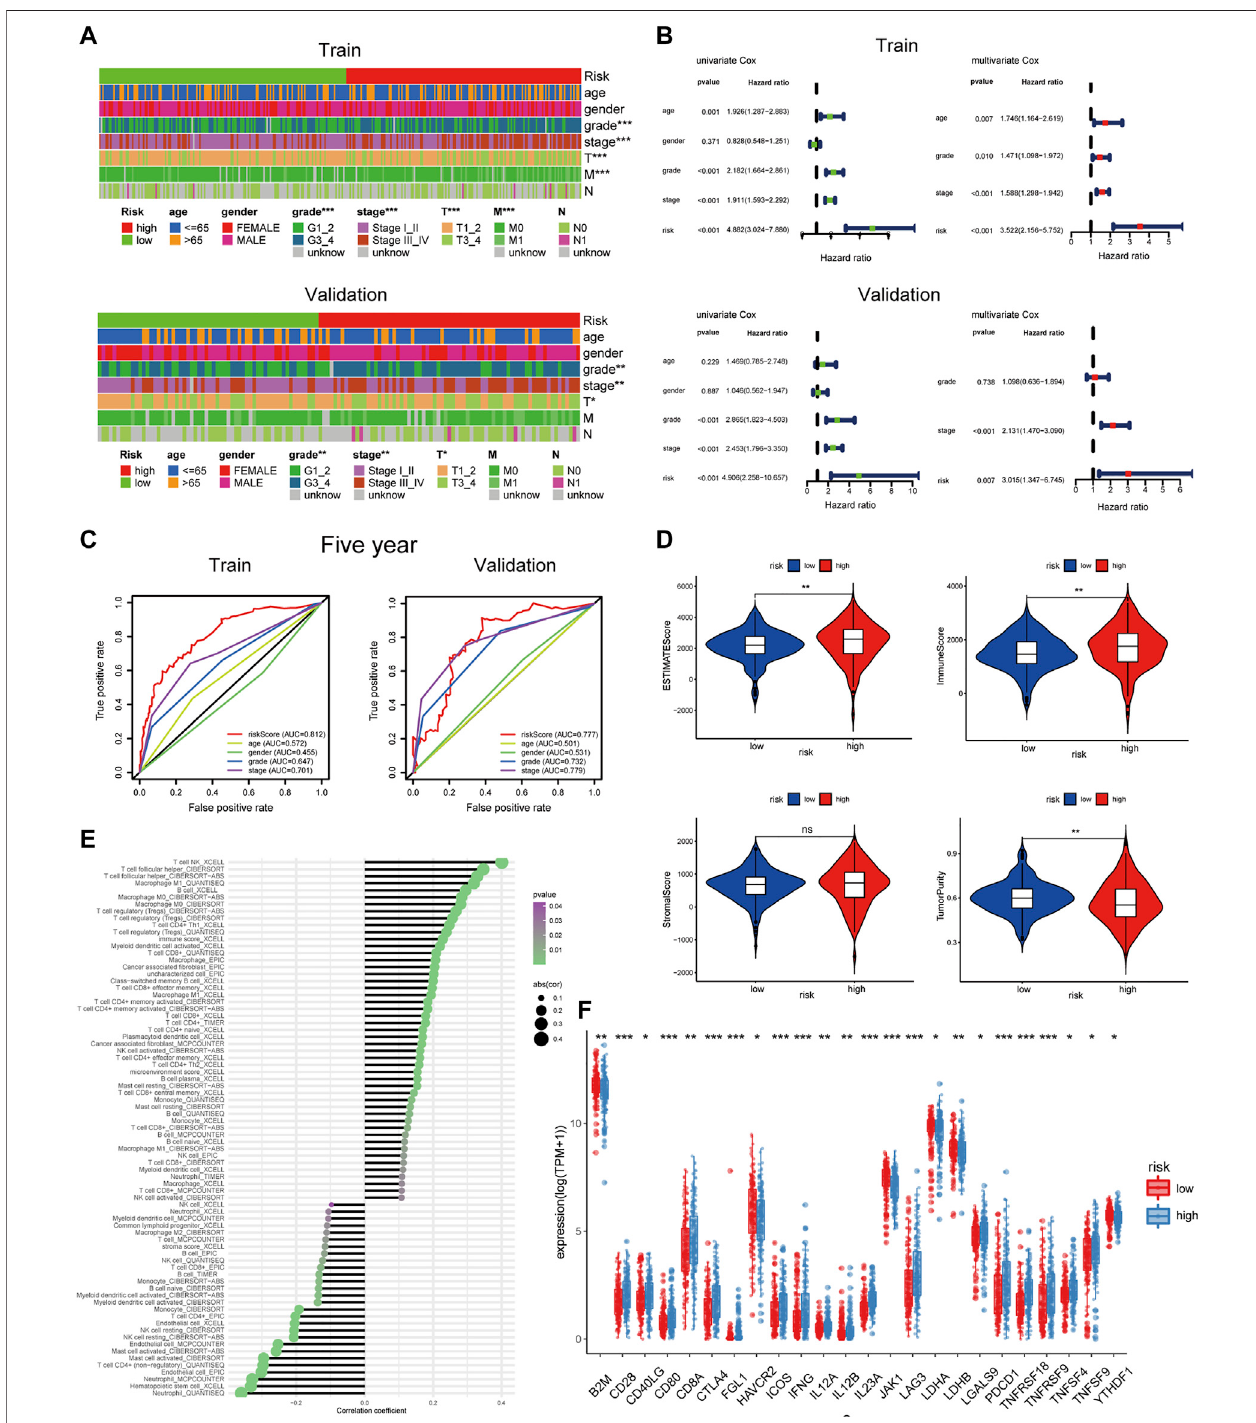
FIGURE 7 | Clinical characteristics and immune in fi ltration of risk groups based on riskScore. (A) The heatmap reveals the distribution of clinical characteristics in patients in the high- and low-risk groups. (B) Univariate and multivariate Cox regression analyses showed that risk was an independent prognostic factor. (C) The receiver operating characteristic curve ofriskScoreand clinical features. (D) Different levels of estimate score, immune score, stromal score, and tumor purity in different risk groups. (E) Lollipop chart of tumor-related in fi ltrating immune cells on the basis of TIMER, CIBERSORT, CIBERSORT-ABS, QUANTISEQ, MCPCOUNTER, XCELL, and EPIC algorithms in different risk groups. (F) The expression levels of common immune checkpoints in different risk groups (*** p < 0.001, ** p < 0.01, * p < 0.05).